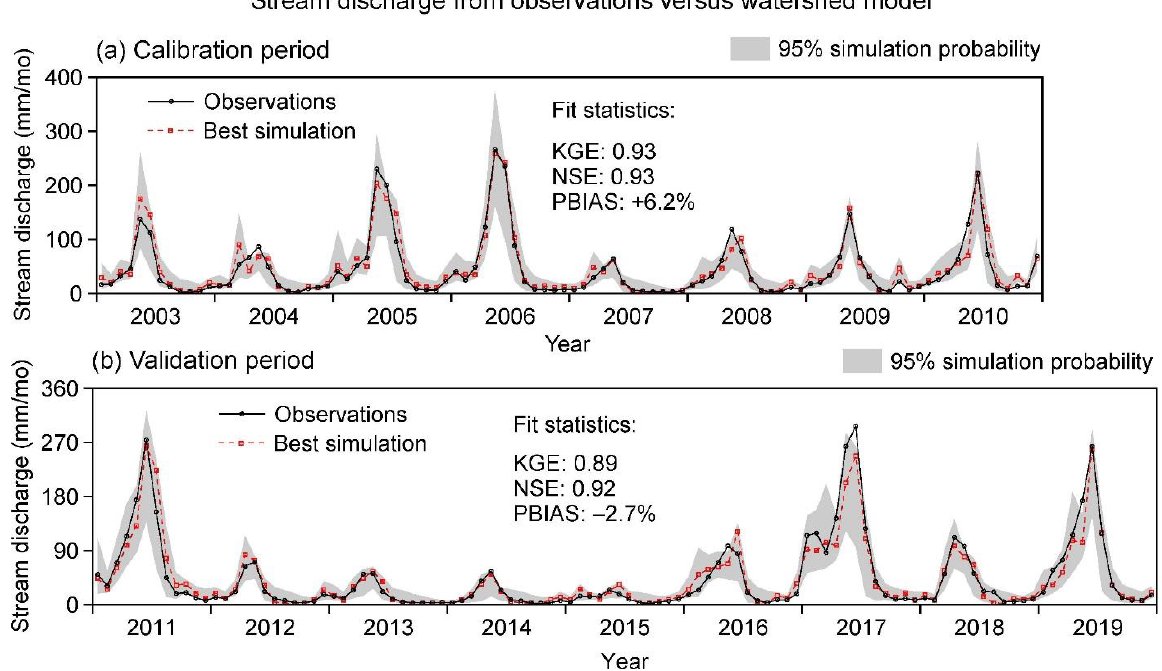
Figure 2. Monthly stream discharge at Pine Flat Dam from observations versus best simulation of SWAT watershed model. 95% simulation probability also shown, defined at the 2.5– to 97.5–percentile of monthly simulations. Fit statistics are for “best simulation” having the highest objective function, i.e., the Kling-Gupta efficiency (KGE) [71]. NSE = Nash-Sutcliffe efficiency [47], PBIAS = model percent bias [48].